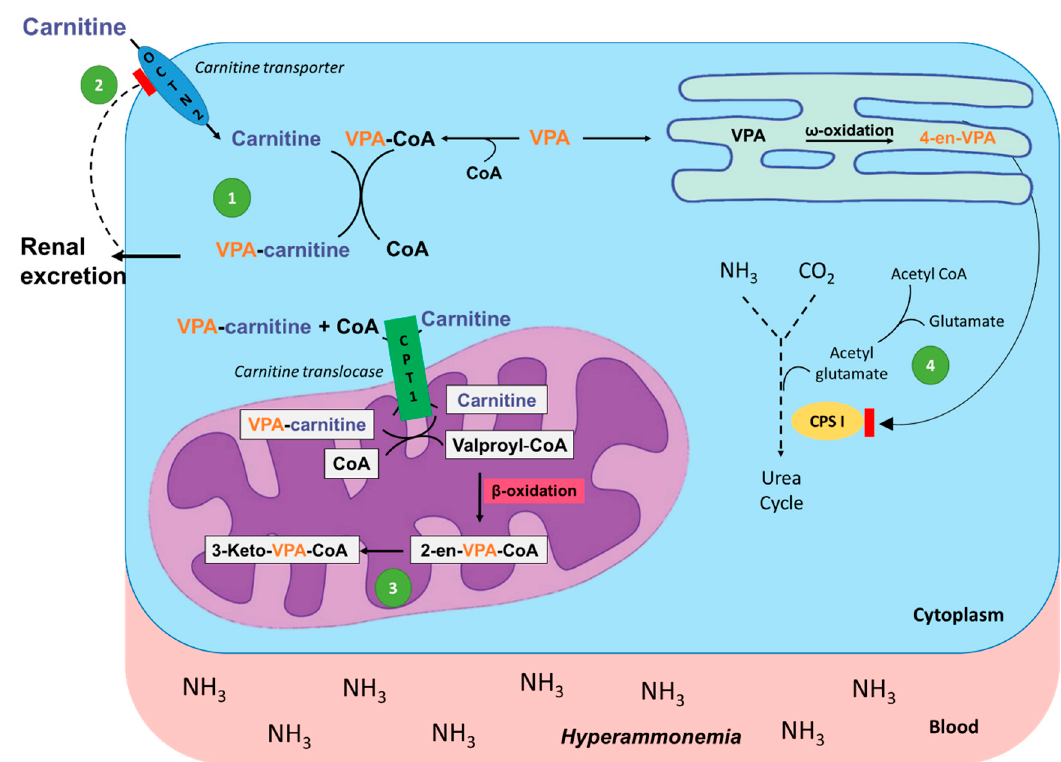
Figure 2. Mechanism of valproic acid (VPA)-induced hyperammonemia. ( 1 ) VPA is attached to coenzyme A (CoA) and transferred to LC creating VPA-carnitine, which is then renally excreted. ( 2 ) VPA-carnitine inhibits an ATP-dependent carnitine transporter, effectively blocking LC entry into the cell. ( 3 ) Other VPA metabolites, 2-en-VPA and 3-Keto-VPA, trap mitochondrial free CoA so that it cannot participate in ATP production, further inhibiting the ATP-dependent carnitine transporter. ( 4 ) The decrease in free CoA and LC results in decreased formation of N-acetylglutamate, which is a necessary co-factor for carbamoylphosphate synthetase I (CPS I), the primary enzyme of the first steps of the urea cycle. This leads to the accumulation of ammonia as it can no longer be incorporated into urea and excreted, resulting in hyperammonemia.